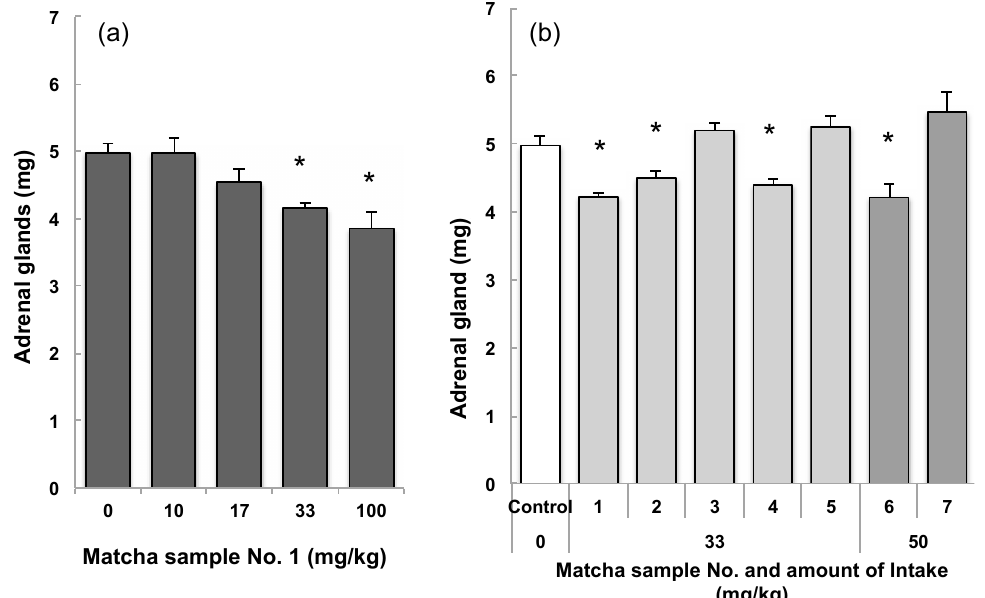
Figure 1. Suppression of adrenal hypertrophy by matcha intake in stressed mice. ( a ) Mice consumed a matcha sample (no. 1) in a powder diet for seven days (single rearing for six days and confrontational rearing for one day). Since each mouse (ca. 30 g) ingested about five grams of diet per day, the intake of matcha was set to 0, 10, 17, 33, and 100 mg/kg; ( b ) Mice were fed a diet containing matcha from no. 1 to no. 5 at a concentration of 33 mg/kg, and from no. 6 to no. 7 at a concentration of 50 mg/kg. Each bar shows the mean ± SEM ( n = 4–8; * p < 0.05).